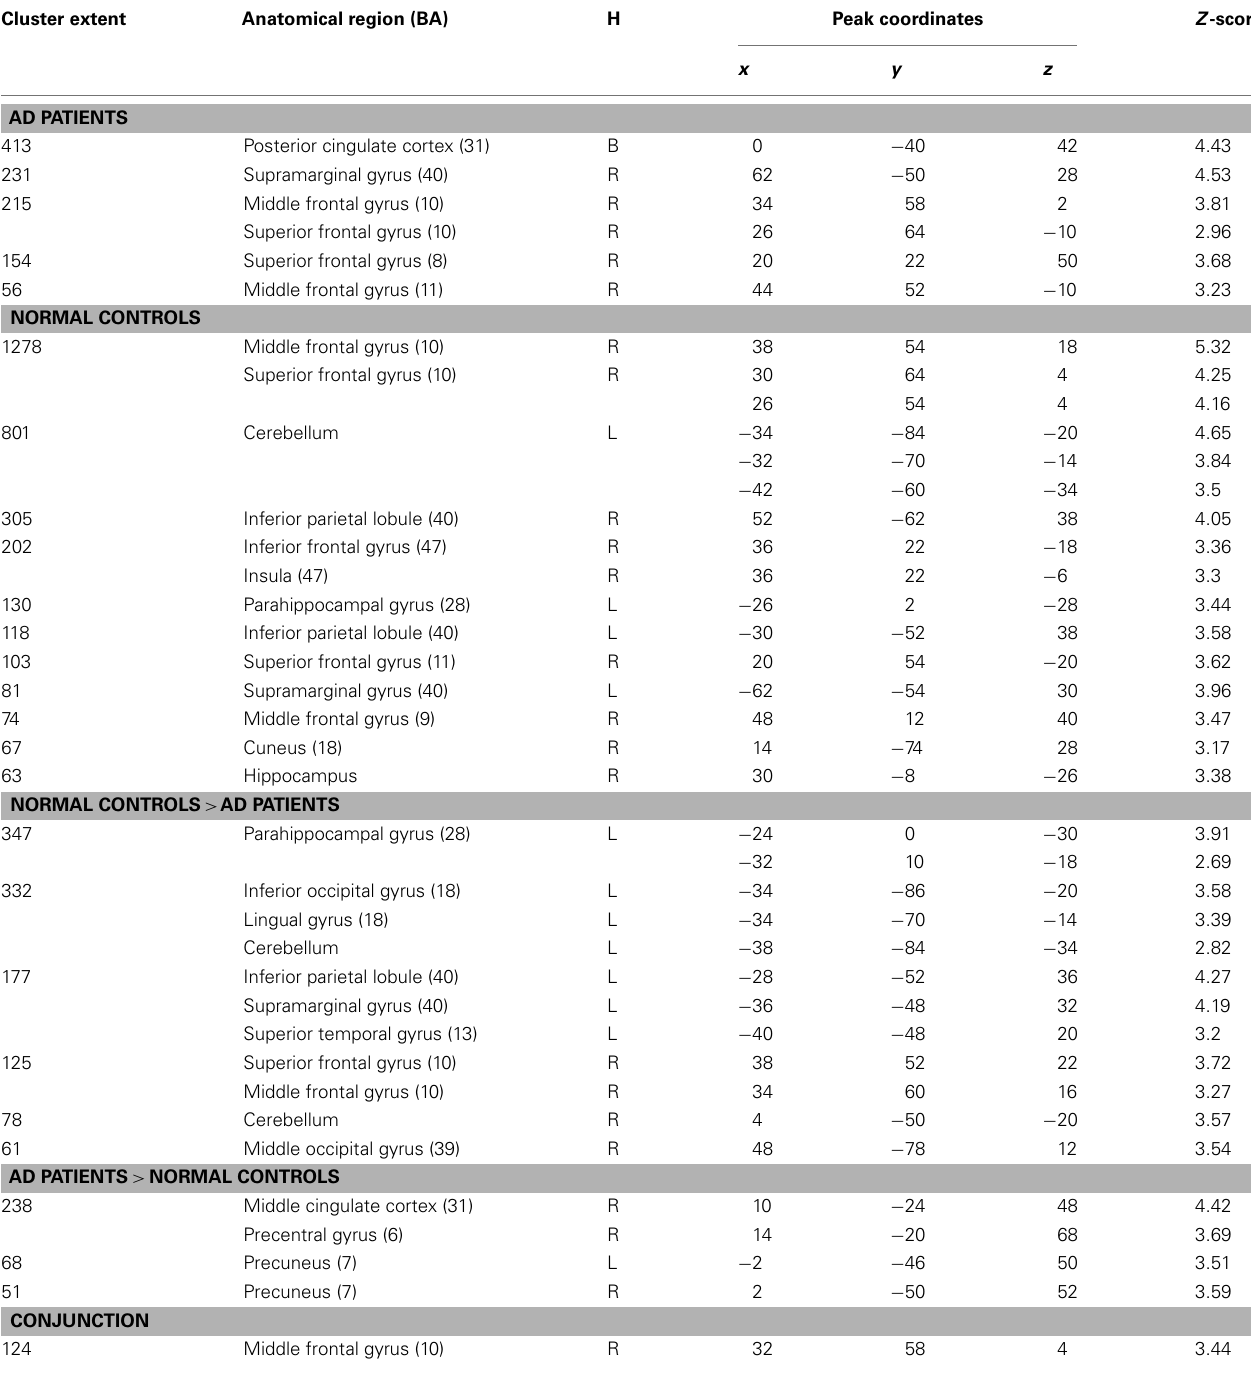
Table 2 | Significant activations for intra- and inter-group comparisons for the (stem-cued recall – stem-completion) contrast ( p < 0.005 uncorrected, cluster extent > 50